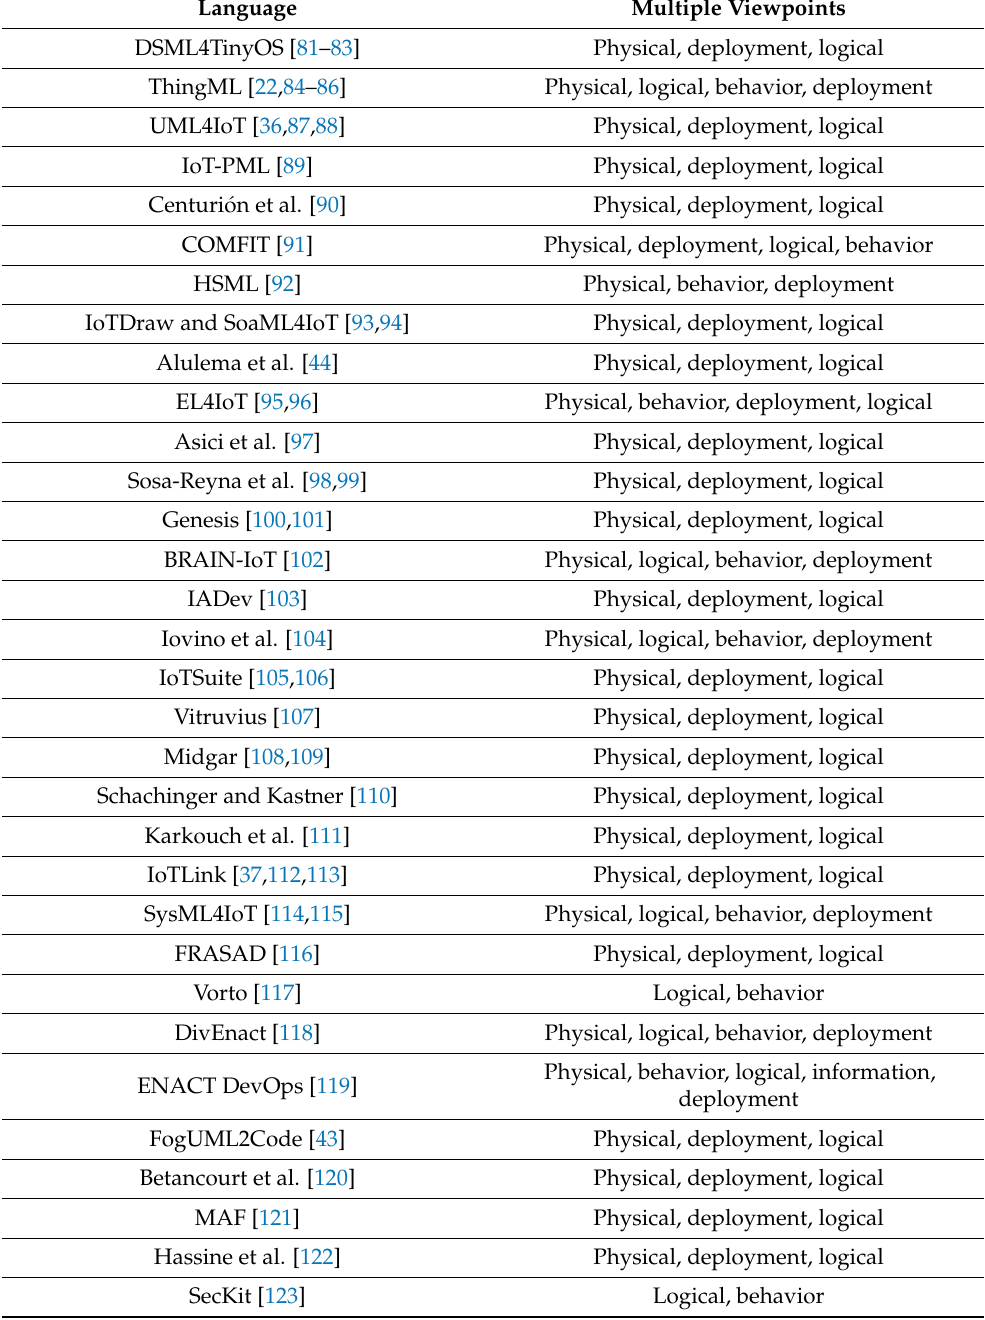
Table 4. The modeling languages for IoT that support multiple